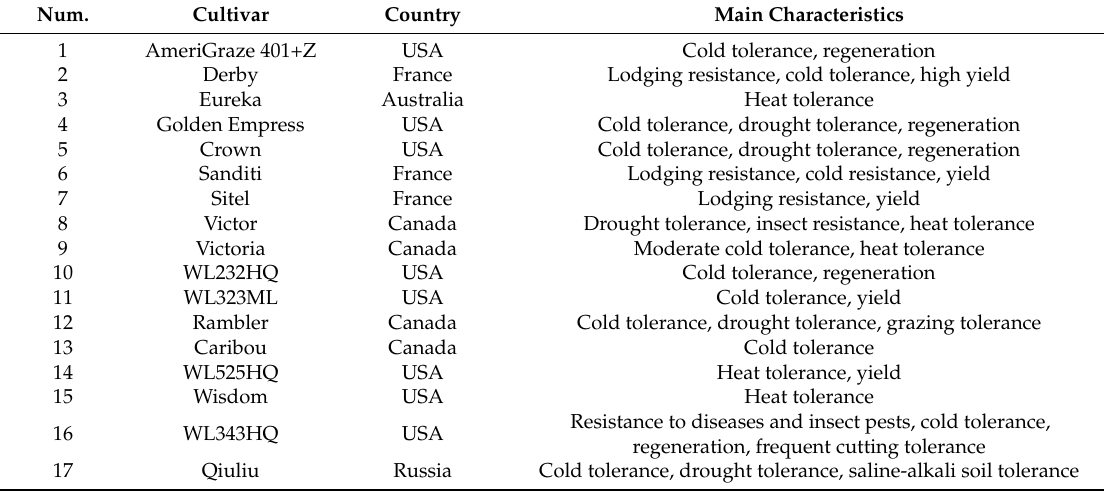
Table 1. Introduced Medicago sativa varieties registered by the National Committee for the Examination and Approval of Pasture Varieties. Num.